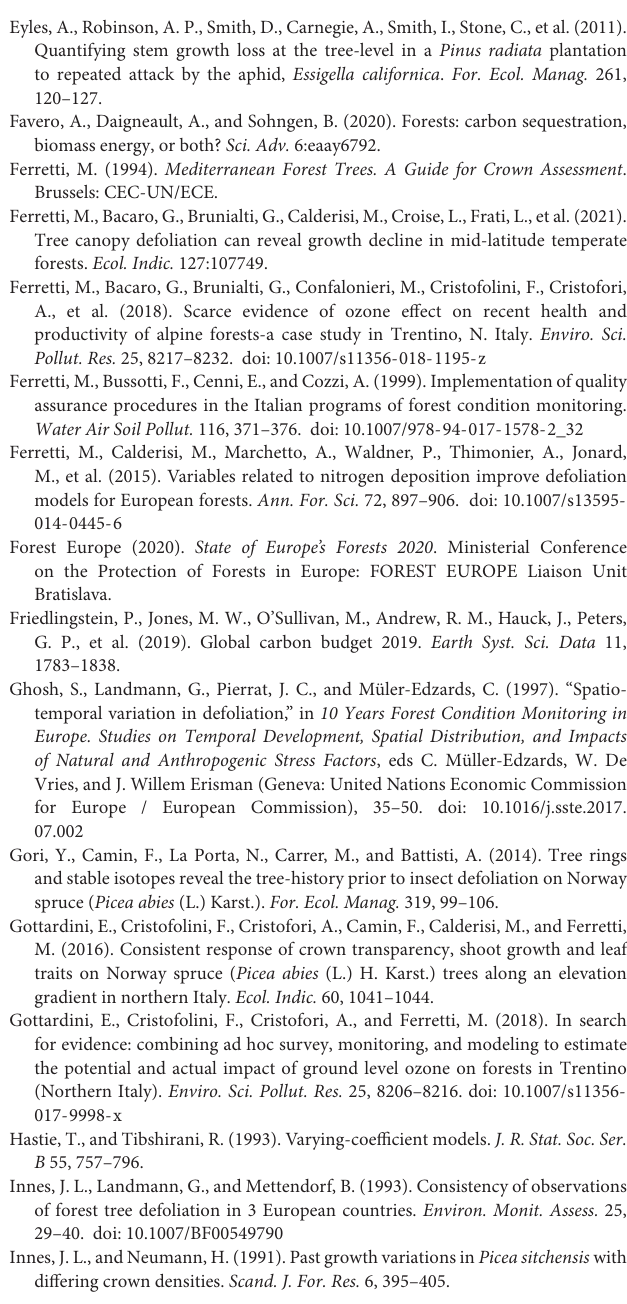
Supplementary Figure 1 | Temporal pattern of mean yearly defoliation and damage from 1997 to 2011, and periodic diameter increment between 2001 and 2005, 2005 and 2009 for: (A) Abies alba Mill., silver fir; (B) Larix decidua Mill., European larch; (C) Pinus cembra L., Swiss pine; (D)